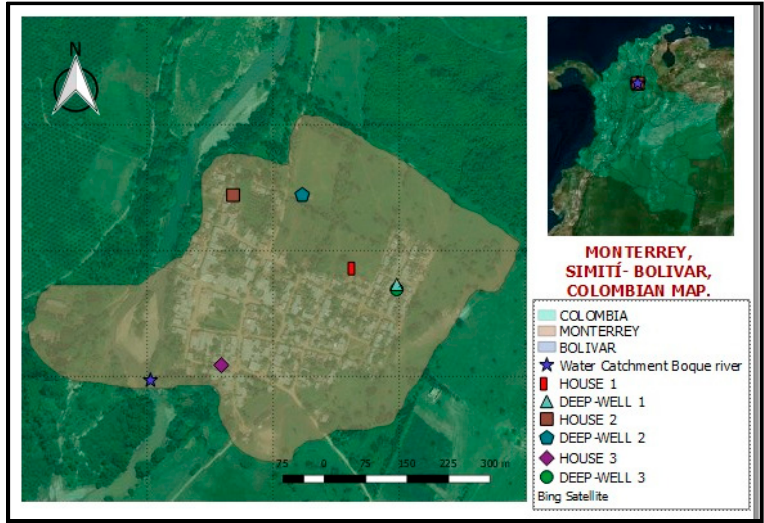
Figure 1. Location of sampling stations in Monterrey, Simití-Bolívar, Colombia. Source: authors.